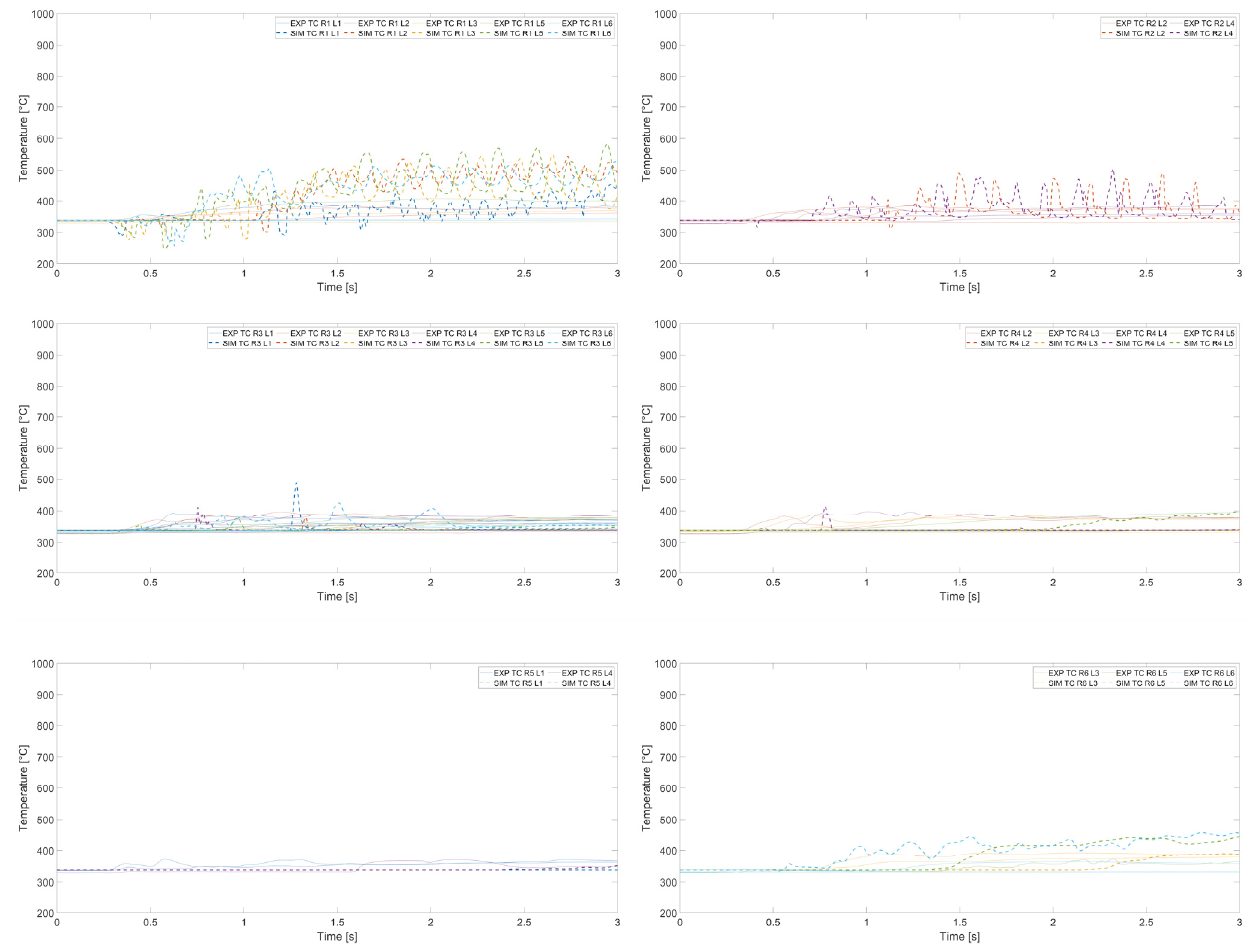
Figure 18. Temperature evolution in S1B for coupled simulations at different radial and axial positions (refer to Table 5).